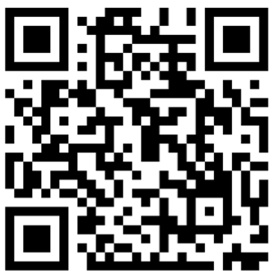
Figure 3. QR code—All commands of Stata that were used in this investigation.